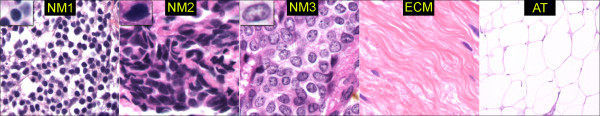
Tissue microtextures identified using image processing. The first three columns show examples of cell nuclei belonging to nucleus morphology categories NM1, NM2, and NM3, respectively. The textures identified as ECM and AT represent, respectively the collagen-rich stroma, and fat and tissue-devoid regions of the slide.